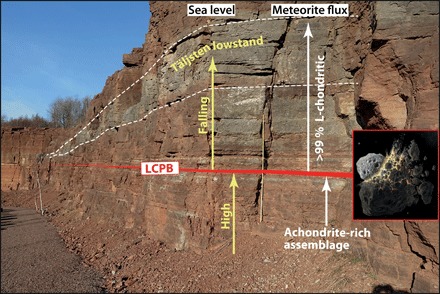
The mid-Ordovician Hällekis section in southern Sweden.The red line represents the stratigraphic level (at −1 m in this study) that corresponds to the time of the breakup of the LCPB in the asteroid belt. At this level, there is a change in the strata in abundance and types of extraterrestrial chrome-spinel grains. A low-abundance, mixed micrometeorite assemblage is replaced by a high-abundance assemblage completely dominated by L-chondritic grains. At the same level, the grain size of bioclastic limestone fragments begins to increase, indicating onset of a gradual sea level fall that culminates with the conspicuous Täljsten lowstand deposit traceable over most of Baltoscandia and likely also globally. Asteroid breakup artwork by Don Davis. (Photo credit: Birger Schmitz, Lund University)